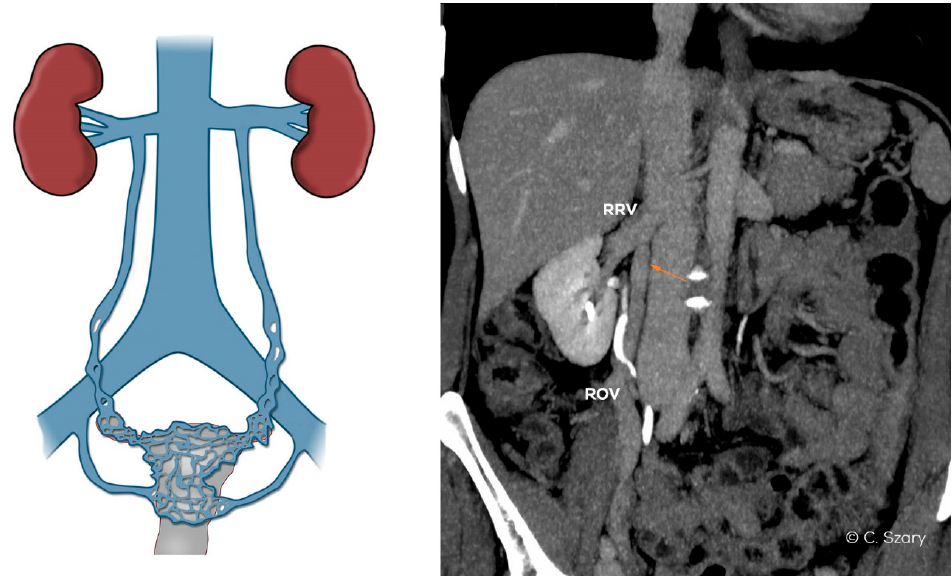
Figure 7. Atypical drainage of insufficient right ovarian vein (ROV) into right renal vein (RRV) on CTV image. The proposed grading of venous insufficiency of the ovarian venous system takes into CTV and MRV,